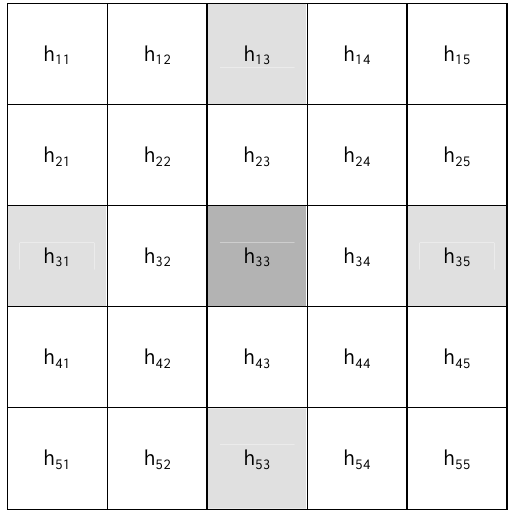
Fig 8. Relief clasification applying height differences between neighbourhood cells Skai č iavimus supaprastinti, gretim ų l ą steli ų aukš č i ų skirtumus gauti galima pagal apskai č iuotus nuolydžius,